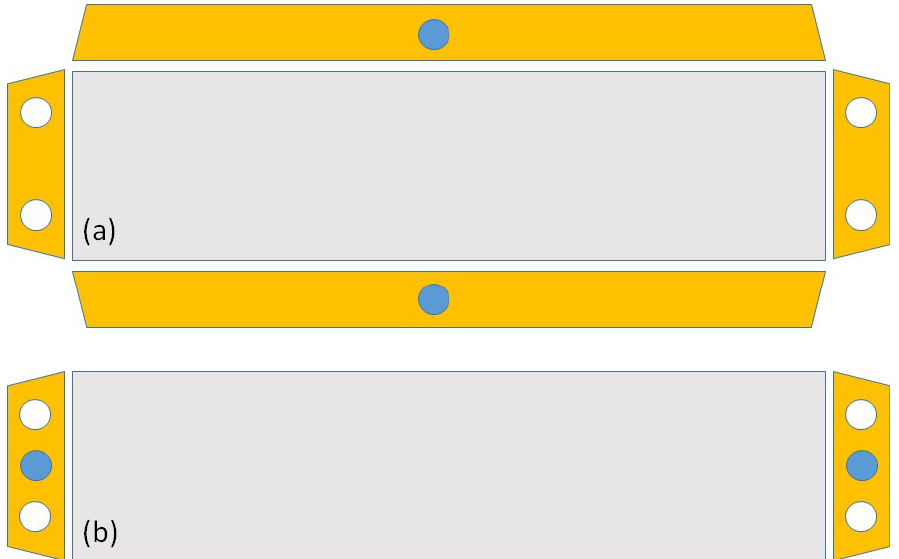
Figure 3. Location of stack manifolds with manifold areas shown in yellow, gas manifolds in white, and coolant manifolds in blue. ( a ) Separate cooling manifolds at the sides and ( b ) combined manifolds in the head and tail